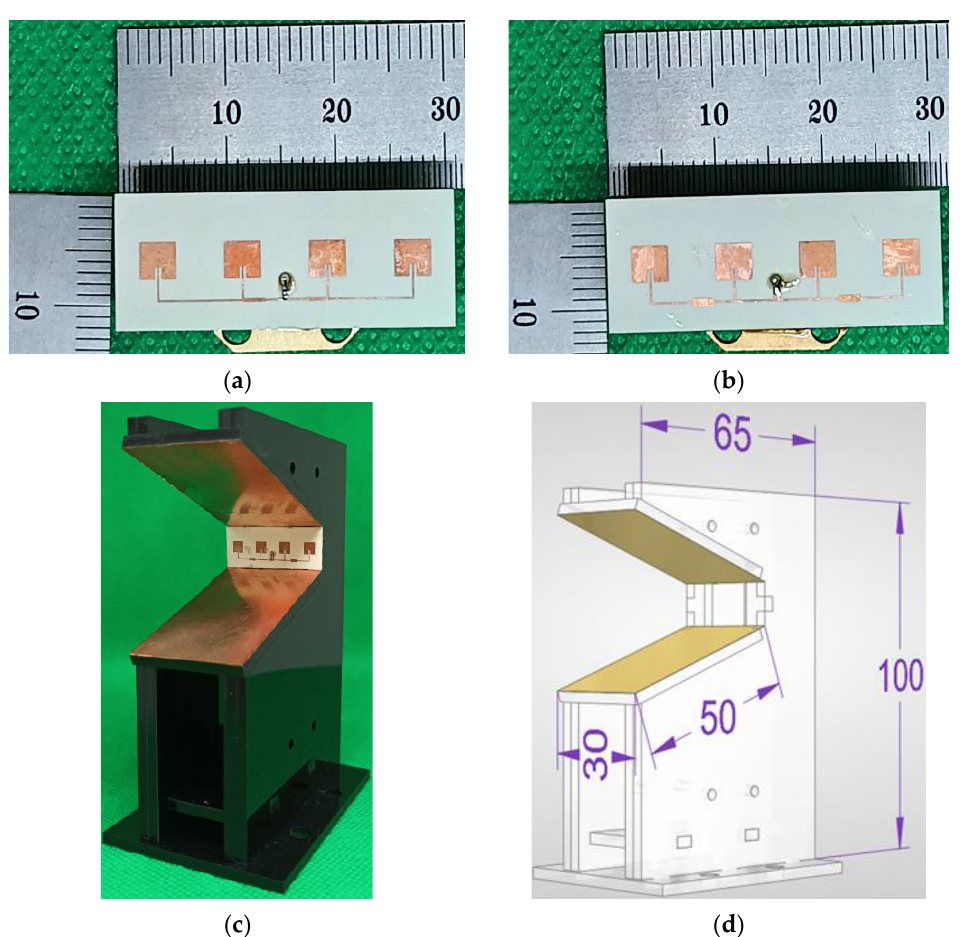
Figure 9. Photographs and dimensions of the fabricated antennas: ( a ) the 4 × 1 array antenna using uniform power distribution, ( b ) the 4 × 1 array antenna using tapered power distribution, ( c ) the 4 × 1 array antenna using tapered power distribution with metallic plates, and ( d ) the dimensions of the acrylic support structure for the metallic plates. (All units are in millimeters).